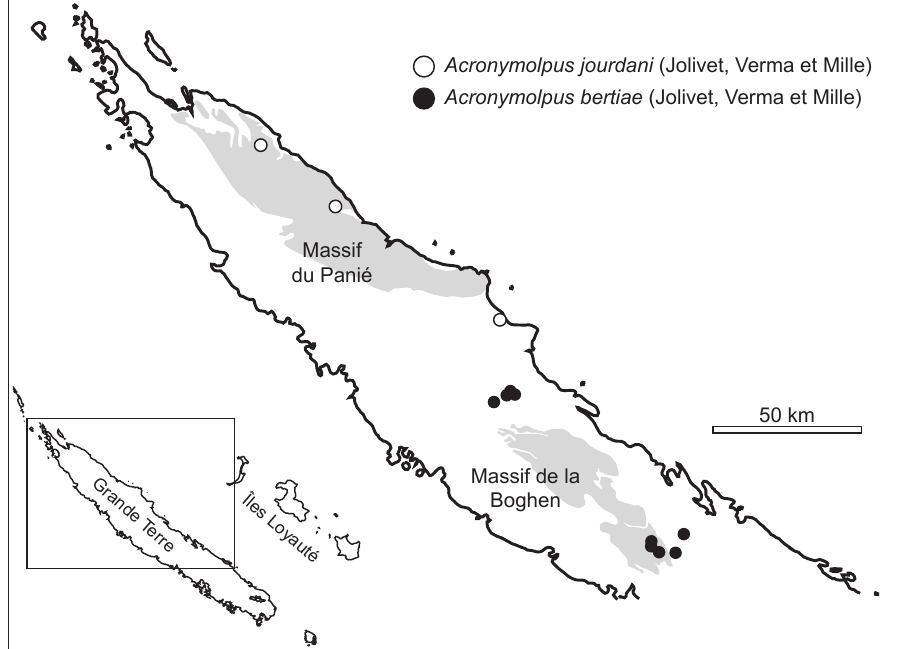
Figure 2. Distribution of Acronymolpus bertiae (Jolivet, Verma & Mille) and A. jourdani (Jolivet, Verma & Mille) in New